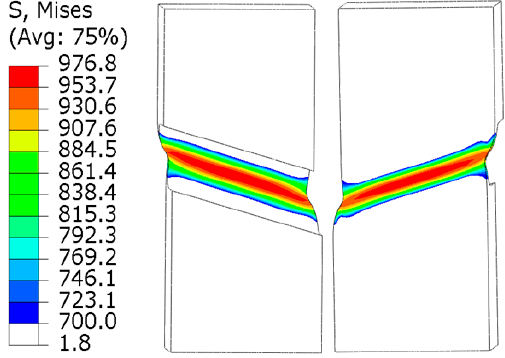
Figure 14. The contour of the von Mises stress.